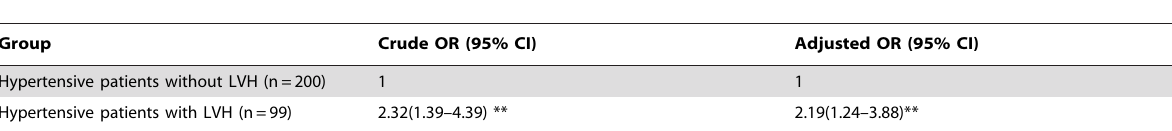
Table 3. Association of the GDF-15 with LVH in hypertensive patients.